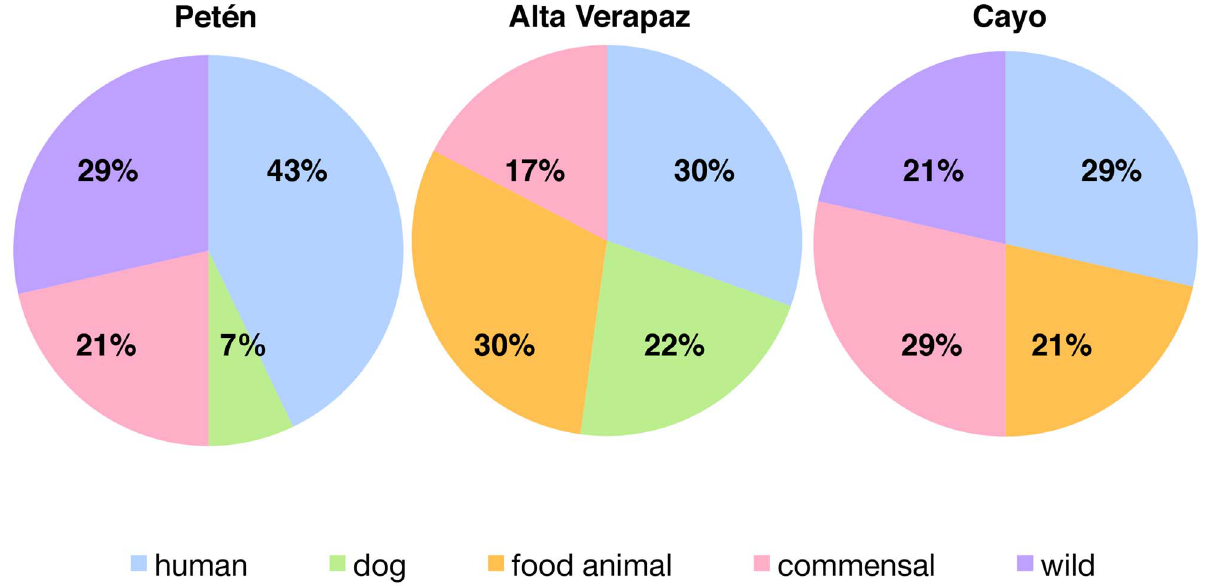
Figure 1. Ecological source of blood meals of Triatomadimidiata collected from caves varies among locations. Vectors were scored as presence/absence for each ecological source. Data are percent of vertebrate host DNA by ecological source cloned from the abdomen of vectors from each location.